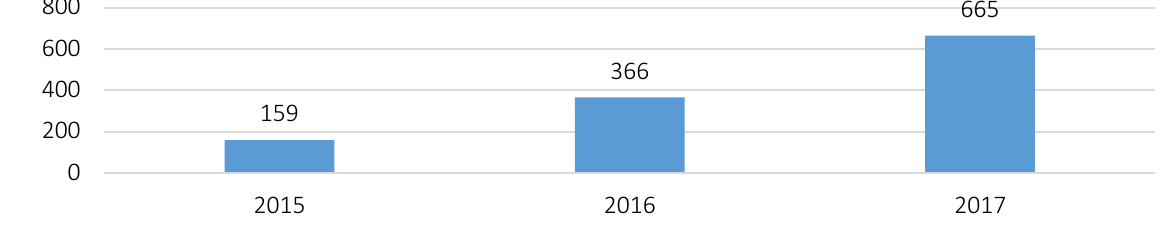
Figure 1. Dynamics of the UTC number in Ukraine in 2015–2017